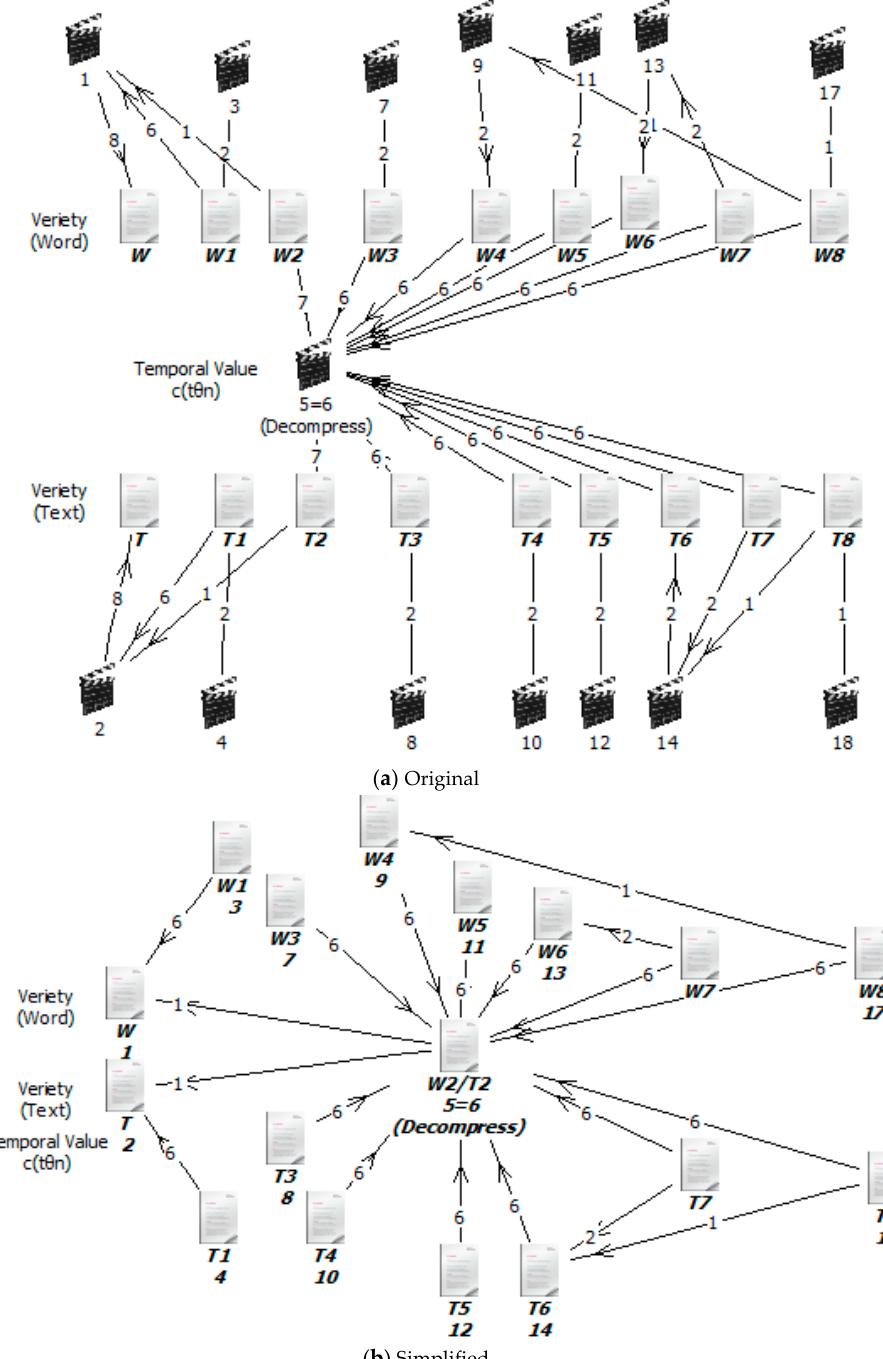
Figure 6. Relational reconstruction from the contact artifacts of temporal values (Case 2).